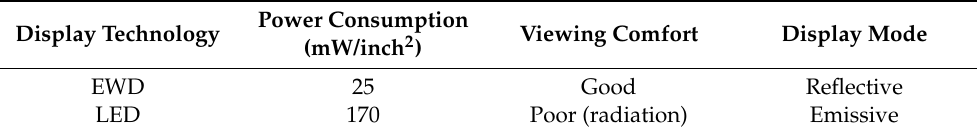
Table 2. Comparison of full-color EWD with LED